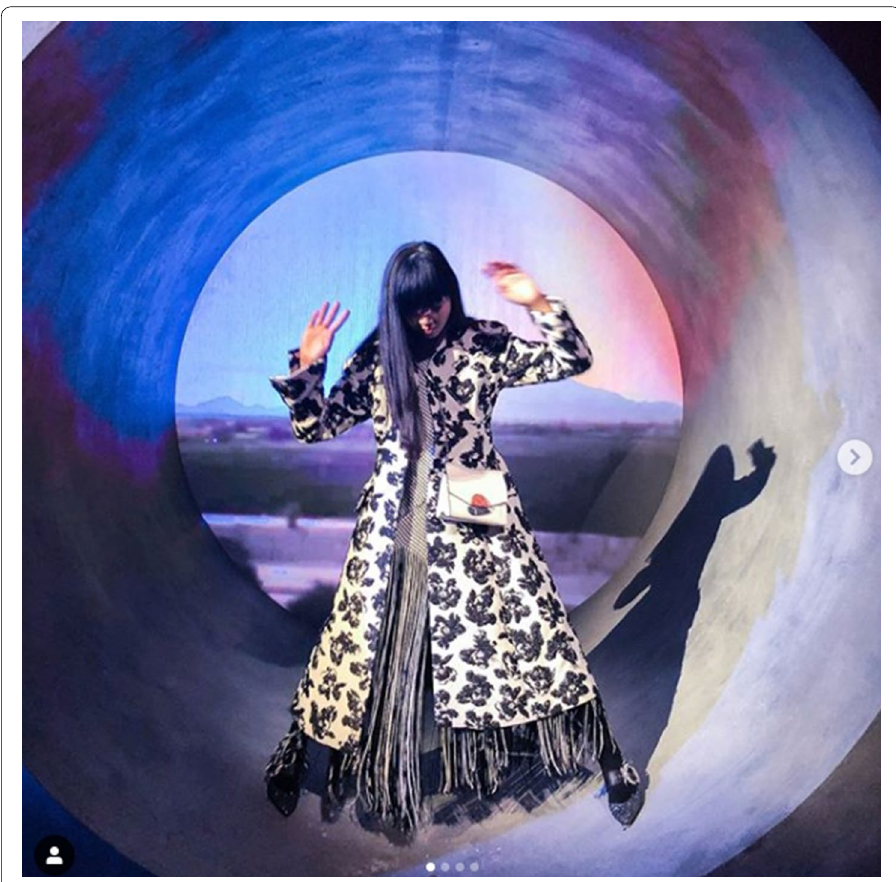
Fig. 15 Dream tripping. https ://www.insta gram.com/p/BfDwQ eWhyw Q/. Accessed 3 October